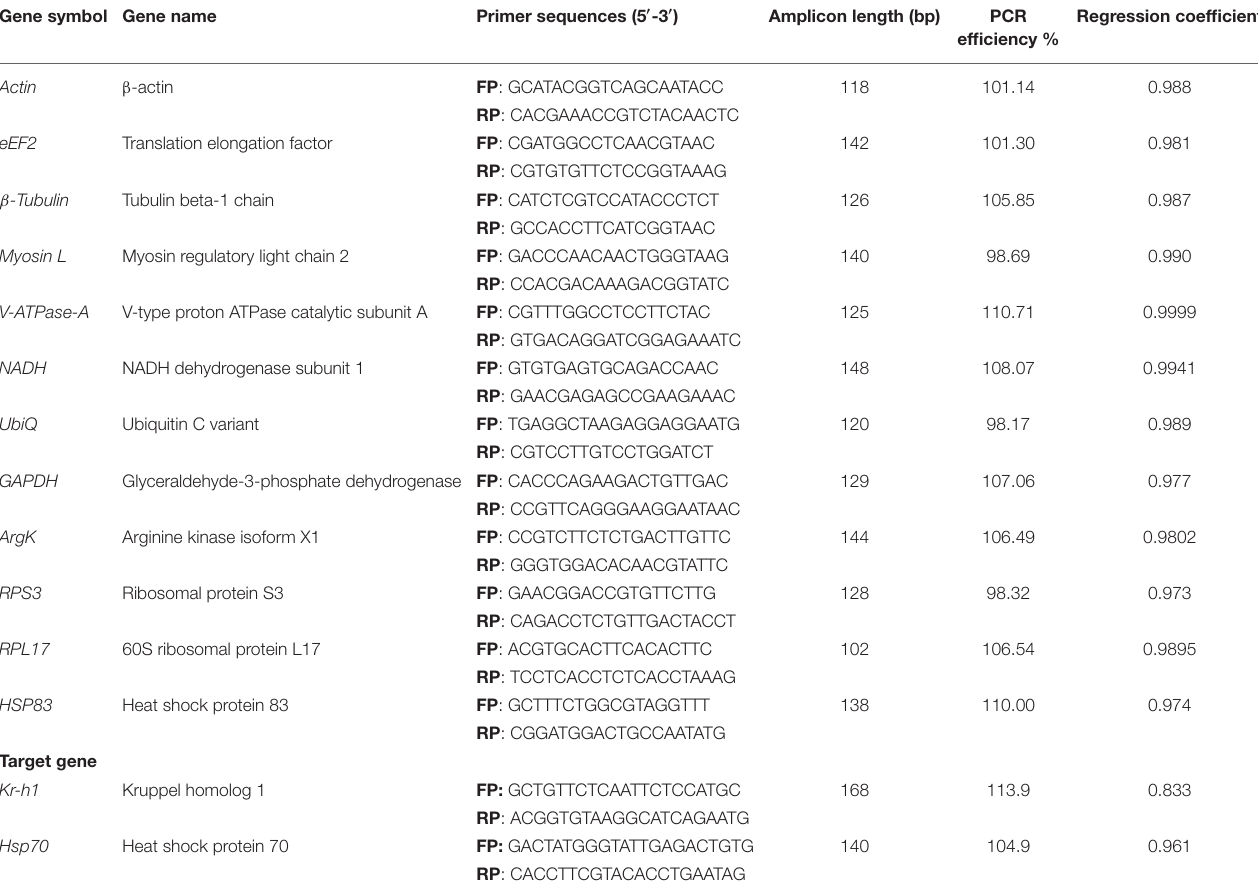
TABLE 1 | Details of primer sequence, amplicon length, and RT-qPCR analysis of candidate reference genes and target